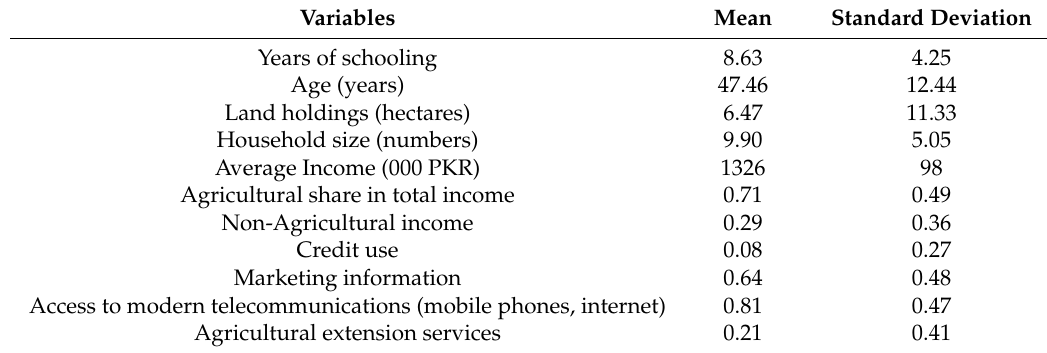
Table 1. Descriptive